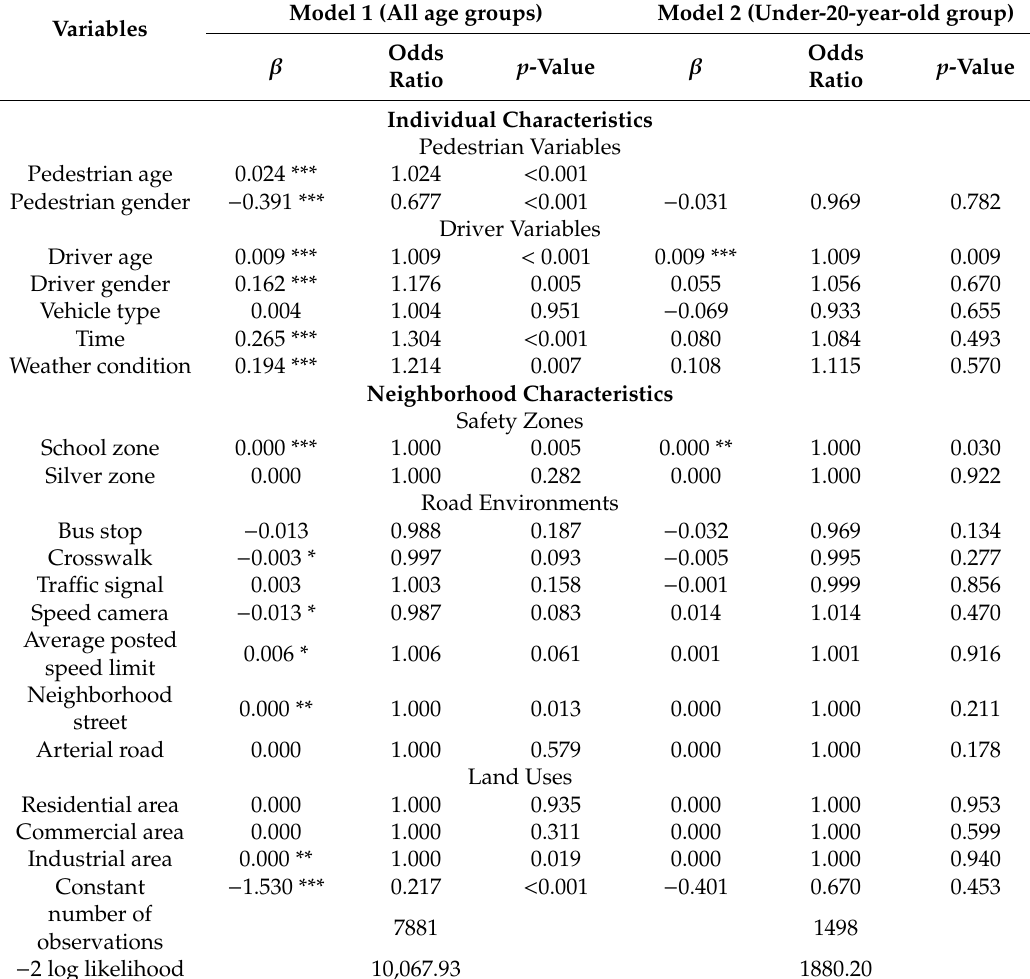
Table 2. The results of binary logistic regression.